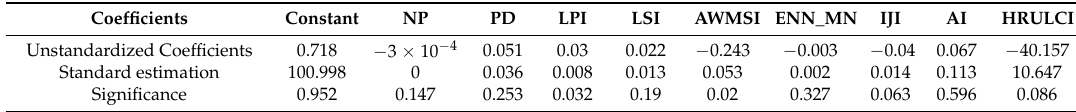
Table 13. The model significance table of NH 3 -N.